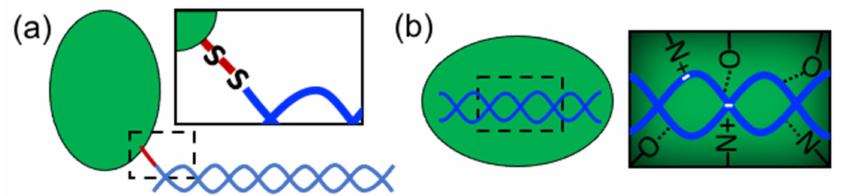
Figure 2. Approaches to link proteins and DNA. ( a ) Covalent conjugation (“S-S” represents a disulfide bridge) and ( b ) noncovalent interactions (dotted lines represent hydrogen bonds).